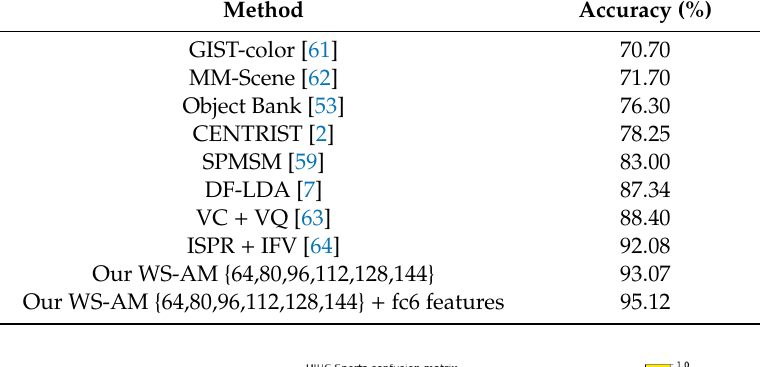
Table 4. Accuracy comparison on UIUC Sports dataset.